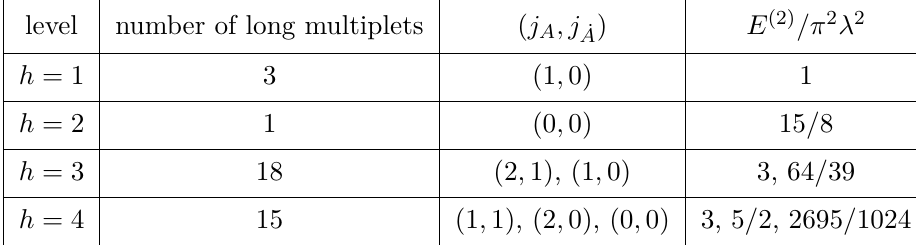
Table 2 . The energy lift at second